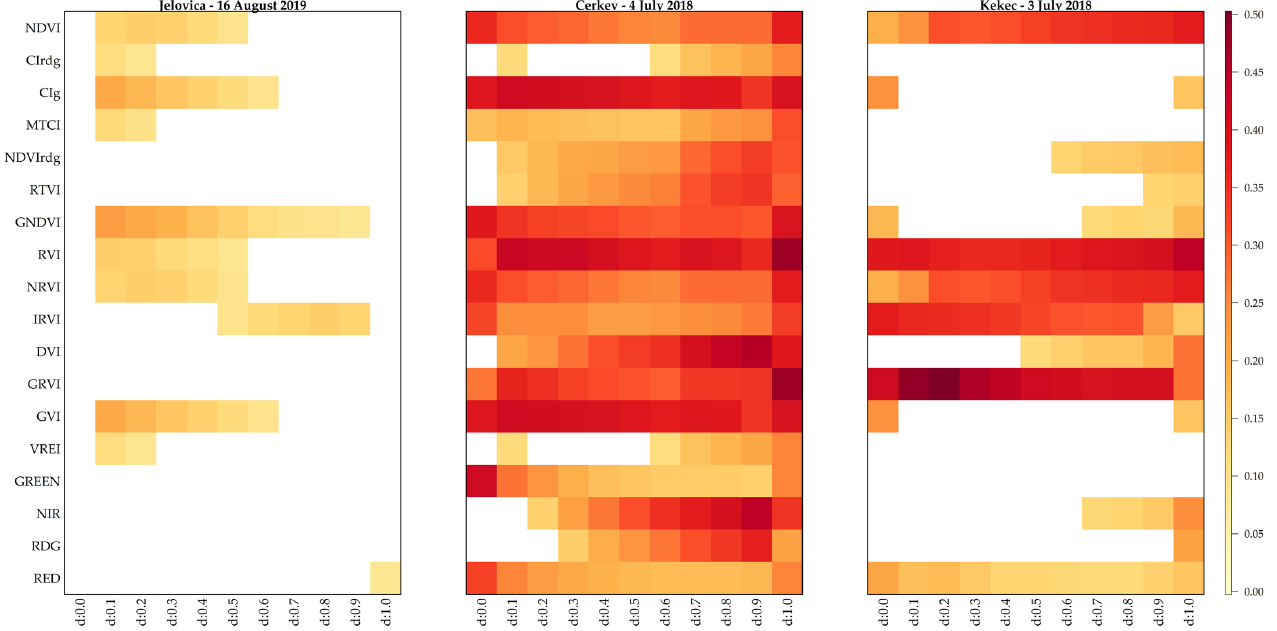
Figure 7. Calculated decile values (x-axis: d) and coefficient of determination (R 2 ) between uninjured and injured trees for each vegetation index (VI) for Jelovica site (rockfall impacts in year 0), Cerkev site (rockfall impacts in year 1), and Kekec site (rockfall impacts in year 6). The results are shown only in cases where there is statistical significance of the results.